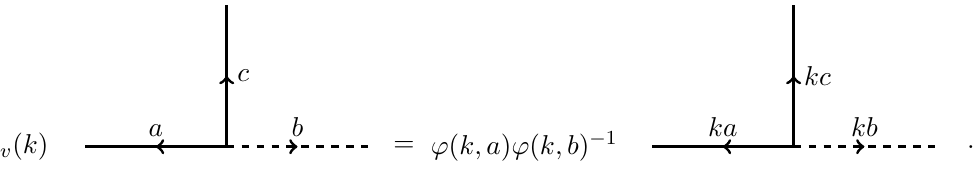
Figure 8 . An illustration of the action of A v operators on the physical